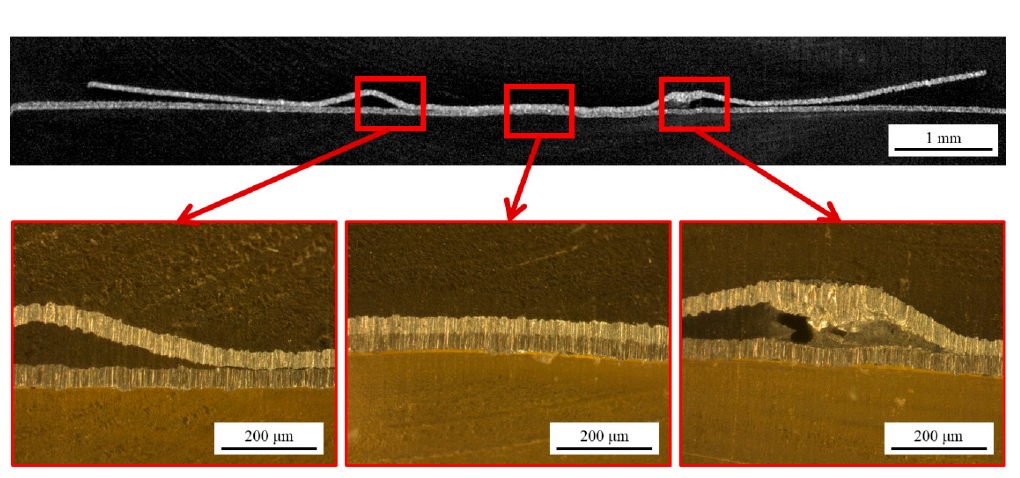
Figure 10. Optical microscope images of different regions of a LIW sample.